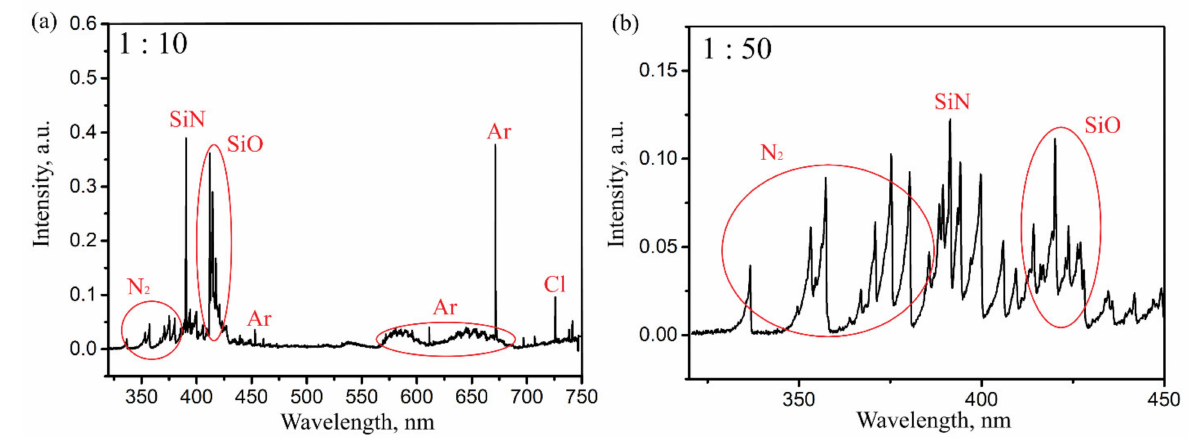
Figure 2. Plasma emission spectra during the synthesis of the oxynitride coating at the ratio of SiCl 4 to N 2 in the deposition zone: ( a ) 1:10, ( b ) 1:50.